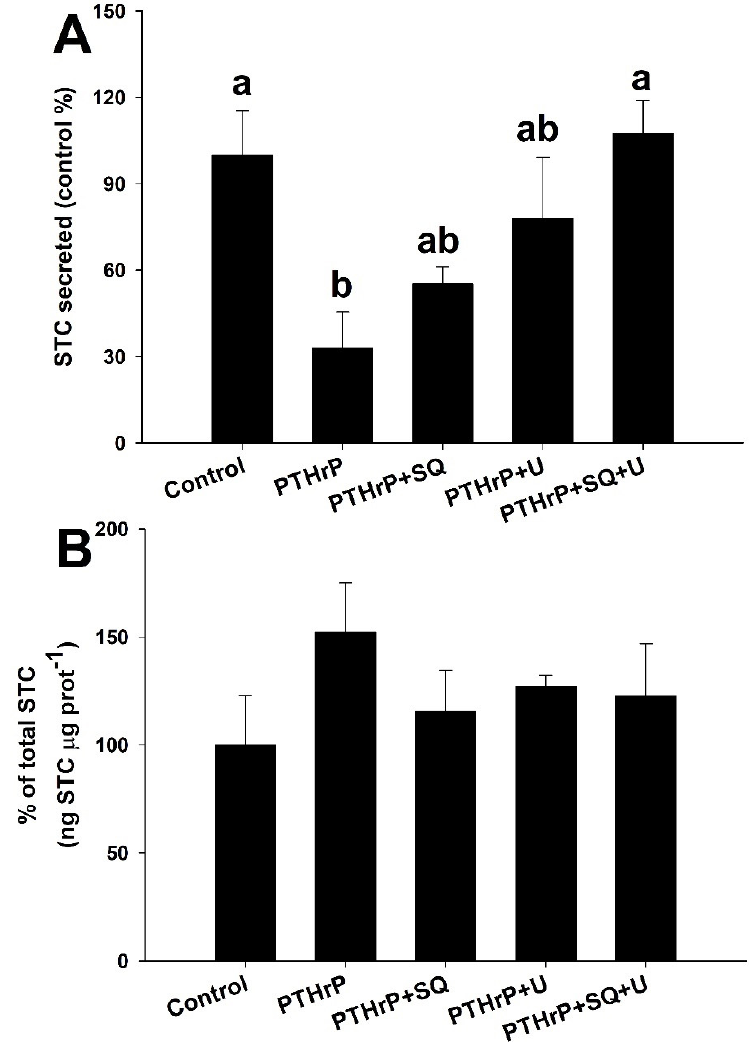
Figure 6. STC ex vivo secretion ( A ) and production ( B ) from the corpuscles of Stannius of the gilthead seabream treated with 100 ng mL − 1 PTHrP alone or with combinations of the adenylyl cyclase inhibitor SQ-22536 (100 µ M, SQ) and the phospholipase C inhibitor U-73122 (10 µ M, U). Control group presents 1.46 mM Ca 2+ and no PTHrP or specific inhibitors (basal STC secretion of 0.19 ± 0.03 ng STC µ g prot − 1 h − 1 , mean ± SEM). Different letters indicate significantly different groups ( n = 6 per group, one-way ANOVA followed by a Tukey ´ s post-hoc test, p < 0.05).